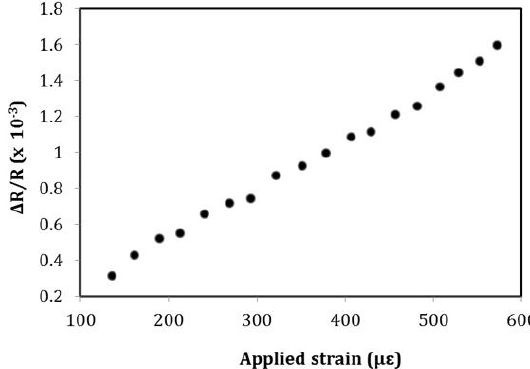
Figure 9. Strain response of the resistive sensors showing the ratio of change in resistance to initial resistance as a result of applied strain.